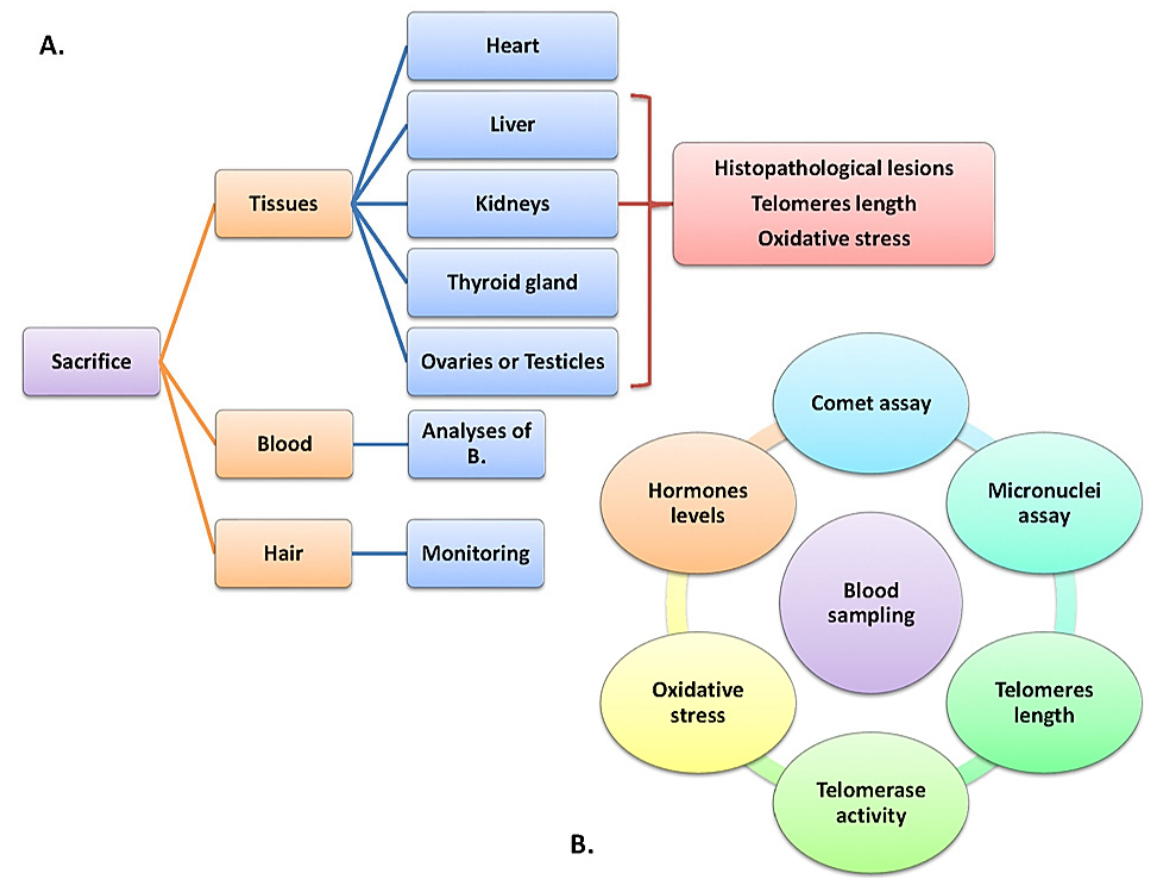
Figure 2. ( A ). Sacrifice procedure: obtained tissues and applied tests ( B ). Blood sampling and applied